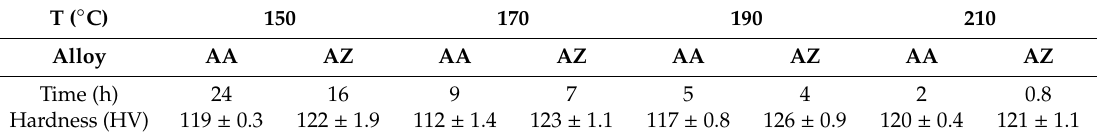
Figure 6. Age hardening curves of the alloy AA and AZ at different temperatures: ( a ) 150 °C, ( b ) 170 °C, ( c ) 190 °C, and ( d ) 210 °C. Table 4. Aging time and hardness of alloys AA and AZ under peak aging conditions at different